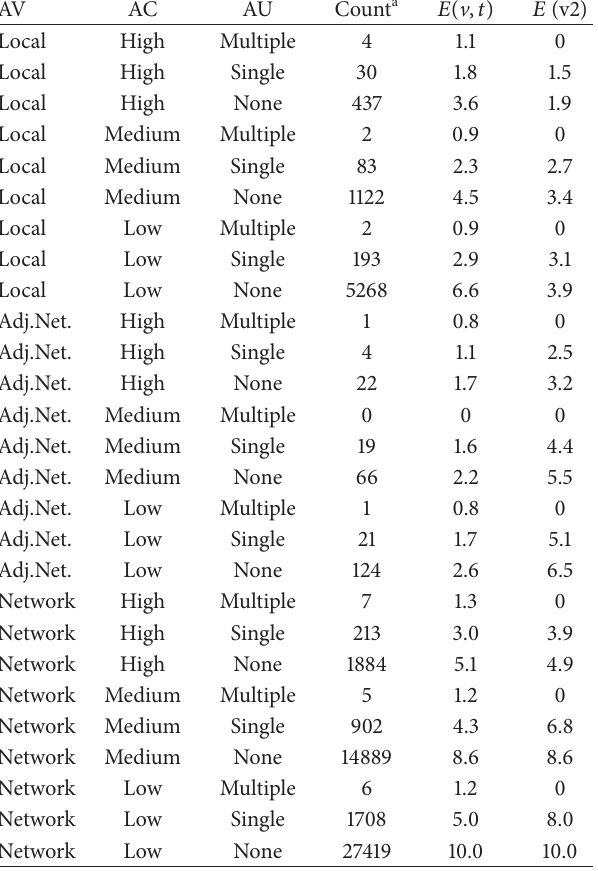
Table 4: Theoretical exploitability score comparison.